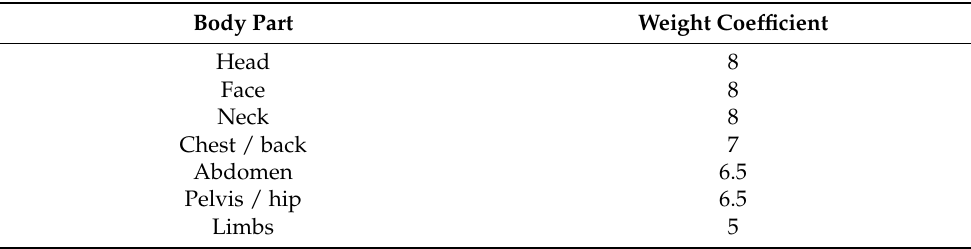
Table 1. Weight coefficients of each body